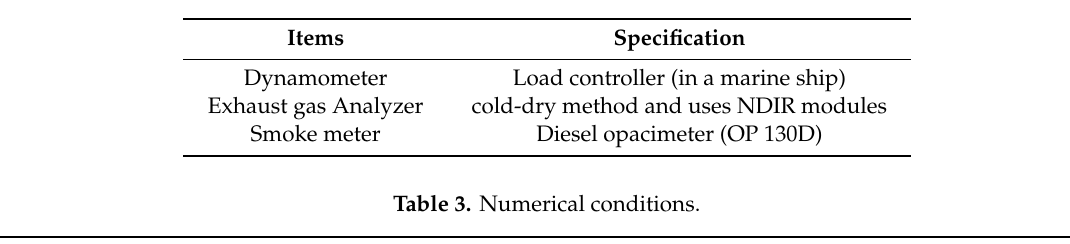
Table 2. Exhaust gas instrument.